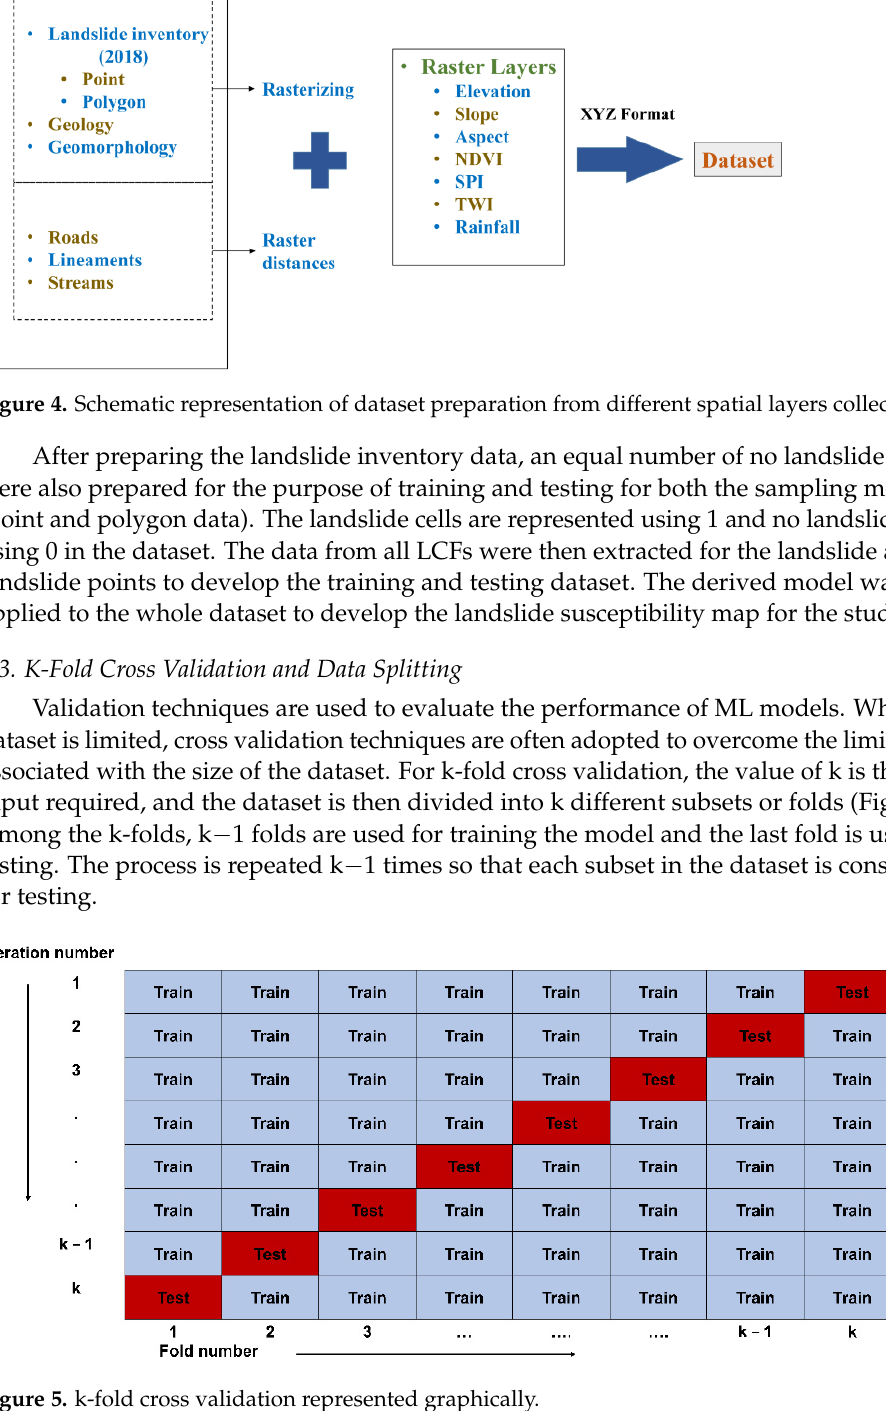
Figure 5. k-fold cross validation represented graphically.